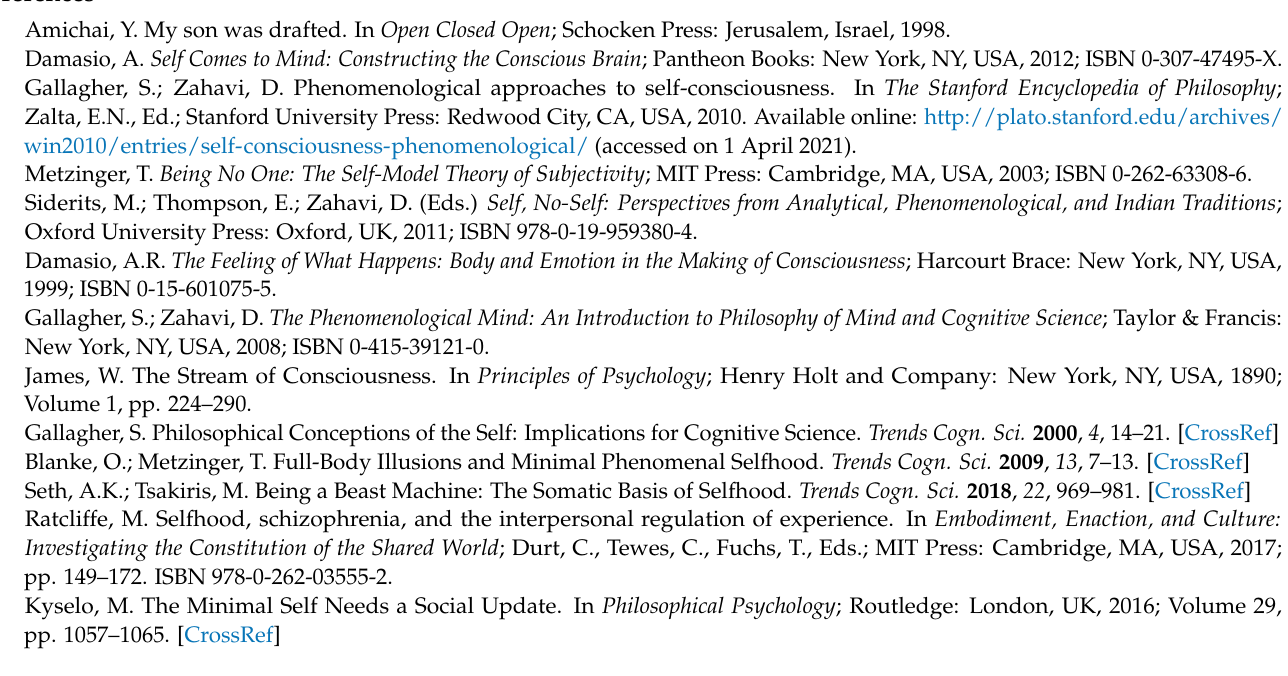
ment; Figure S1: Self-rated depth and stability; Figure S2: Relationships between the phenomeno- logical dimensions in SB − ; Figure S3: Relationships between the phenomenological dimensions in